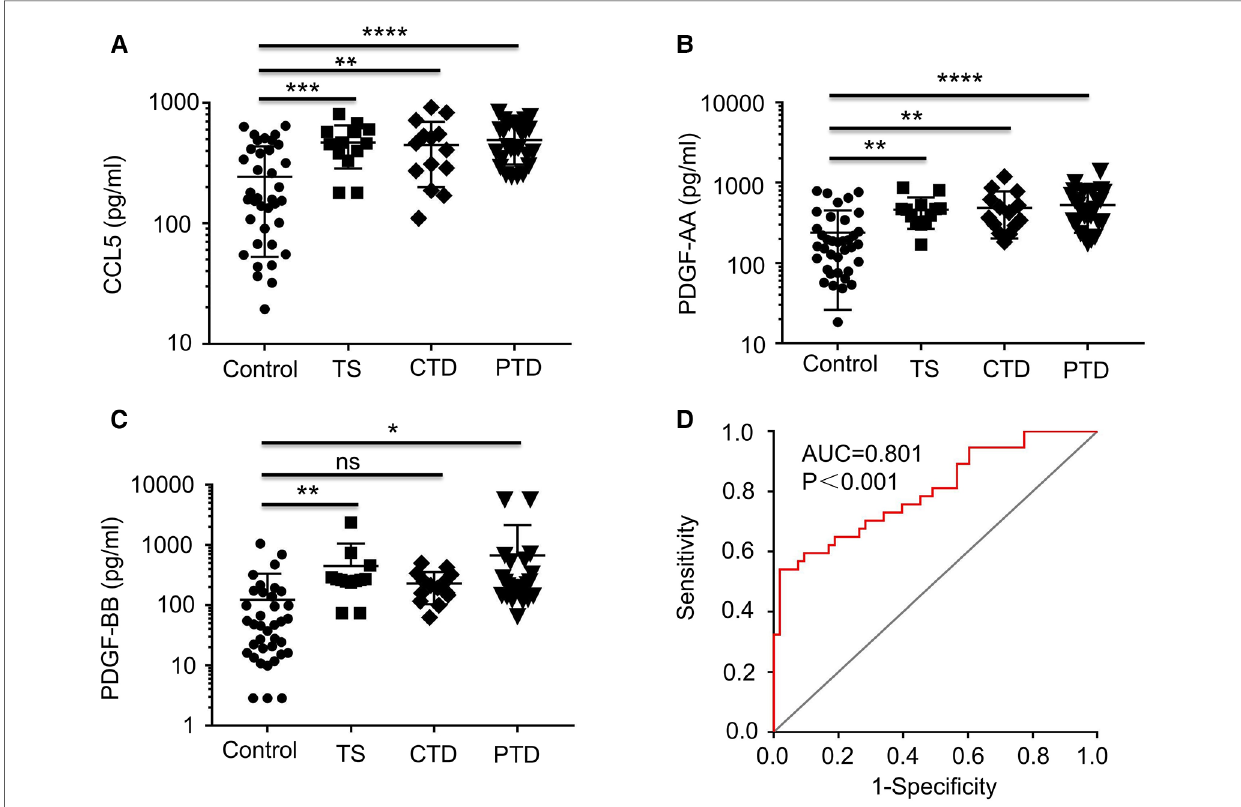
FIGURE 3 Plots showing the levels of plasma CCL5, PDGF-AA, and PDGF-BB. Plots showing the levels of plasma CCL5 ( A ), PDGF-AA ( B ), and PDGF-BB ( C ) from healthy controls and TD patients (TS, CTD, PTD. ( D ) ROC curve analysis combining CCL5 in the differential diagnosis between TD and normal. ROC, receiver operating characteristic; AUC, area under the